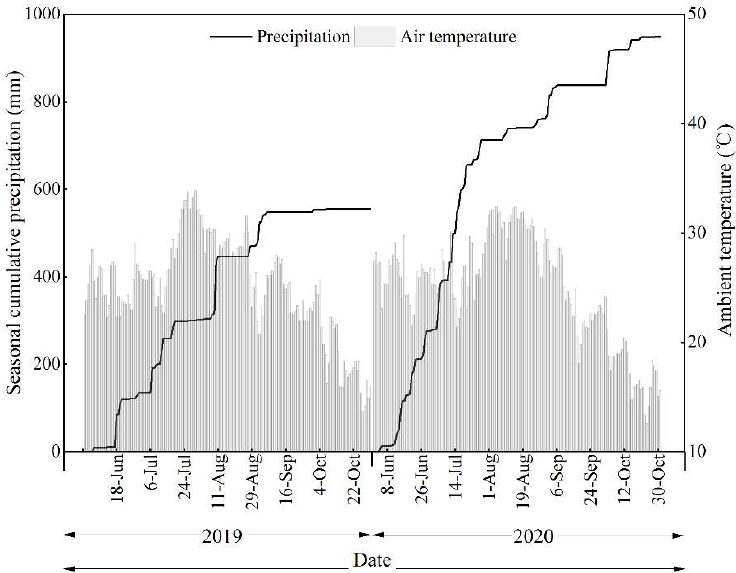
Figure 1. Daily temperature and precipitation for the two sampling seasons.